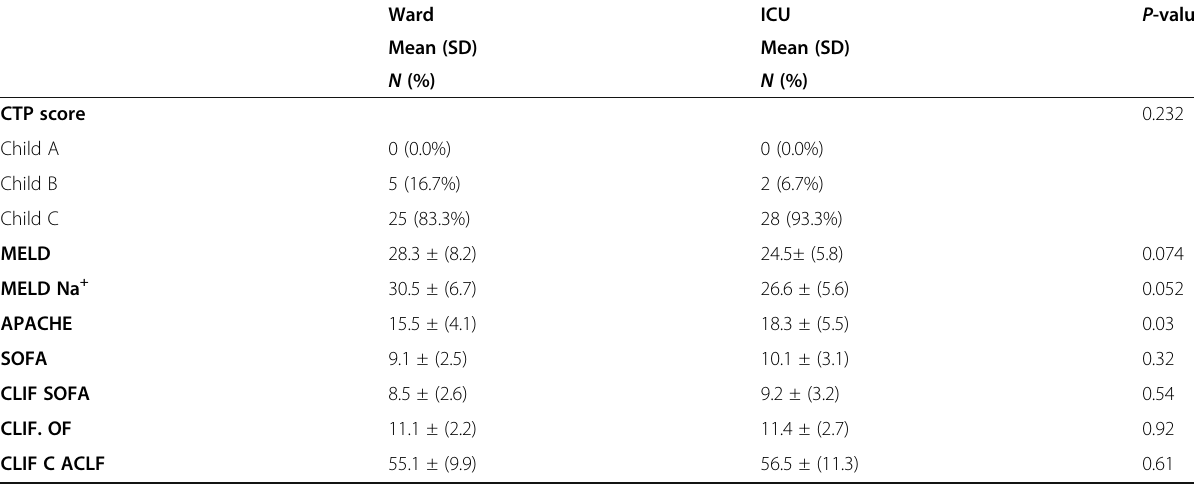
Table 4 Prognostic scores of the 2 studied groups